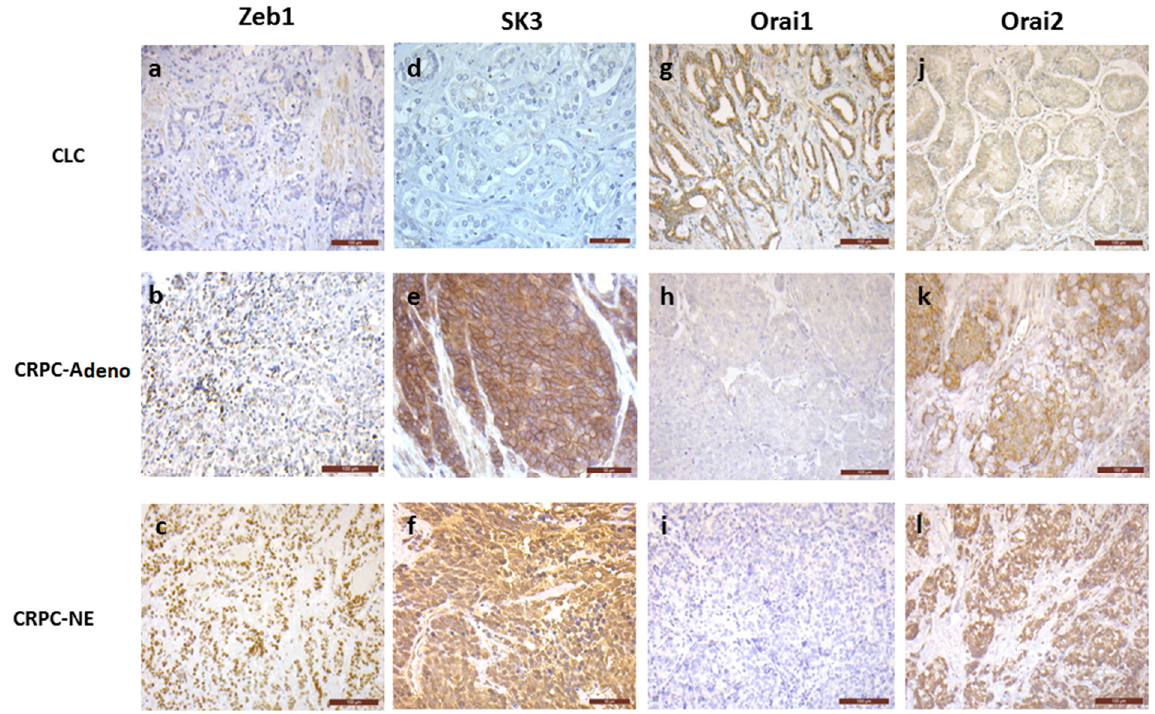
Figure 1. Representative images of immunohistochemical staining of Zeb1 ( a – c ), SK3 ( d – f ), Orai1 ( g – i ) and Orai2 ( j – l ), in human PCa samples. In CLC, most of the cases showed no Zeb1 (1a, bar 100 µ m) and SK3 (1d, bar 50 µ m) expression, while Zeb1 and SK3 positive staining was found in the majority of CRPC-adeno and CRPC-NE samples ( p = 0.01 to < 0.0001) (1bc, bar 100 µ m, 1ef, bar 50 µ m). Orai1 was expressed in most of CLC cases (1g, bar 100 µ m), without any expression in the majority of CRPC–adeno and CRPC-NE samples (1hi, bar 100 µ m) ( p < 0.0001 and 0.004). No Orai2 staining was found in more than 40% of CLC samples (1j, bar 100 µ m), while Orai2 was expressed in more than 80% of CRPC-adeno and CRPC-NE cases (1kl, bar 100 µm) ( p = 0.02 and 0.0004).